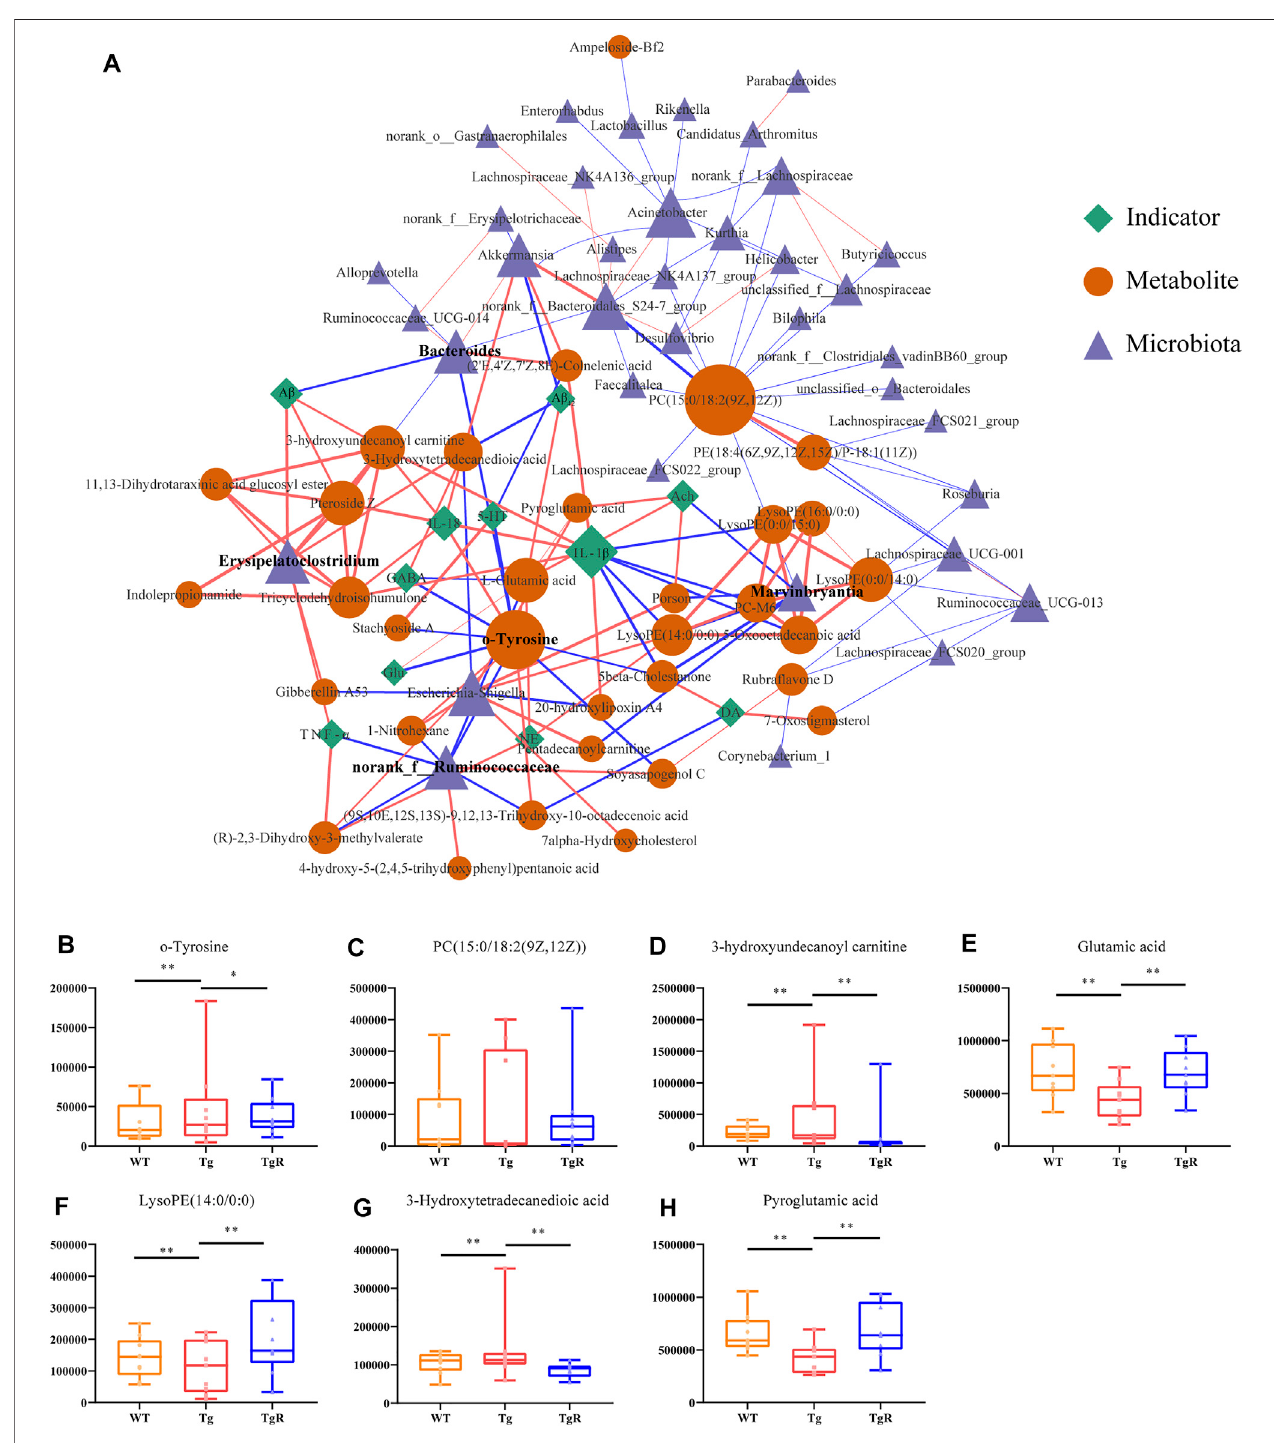
FIGURE 7 | Rhubarb regulates the microbial-metabolite-indicator network of AD model. (A) Correlation network for microbiota, metabolites, and pathological indicators for Tg mice. The blue triangle represents bacteria, the yellow circle represents metabolites, and the green diamond represents physiological and biochemical indicators. Lines between nodes indicate positive (red) or negative (blue) correlations. The width of the line indicates the correlation value. (B – H) Rhubarb regulates abundanceofkeymetabolitesinthenetworkquanti fi edbypeakareas.Valuesareexpressedasthemean ± S.E.M.; n (cid:1) 9;* p < 0.05versusTg;** p < 0.01versusTg; ** p < 0.001 versus Tg, by Student ’ s unpaired t -test.